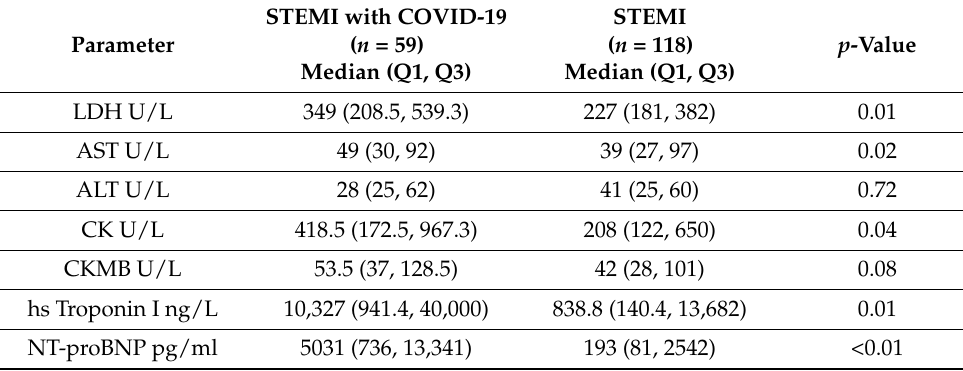
Table 5. Laboratory findings for STEMI patients.